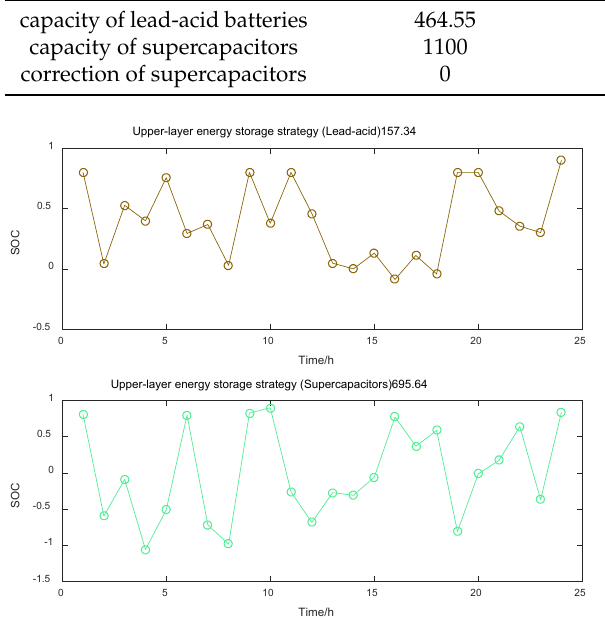
Figure 8. Charging and discharge strategy of the HESSs in Scene 3.